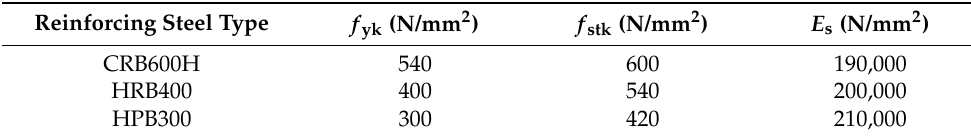
Table 2. Mechanical properties parameters of steel bars.